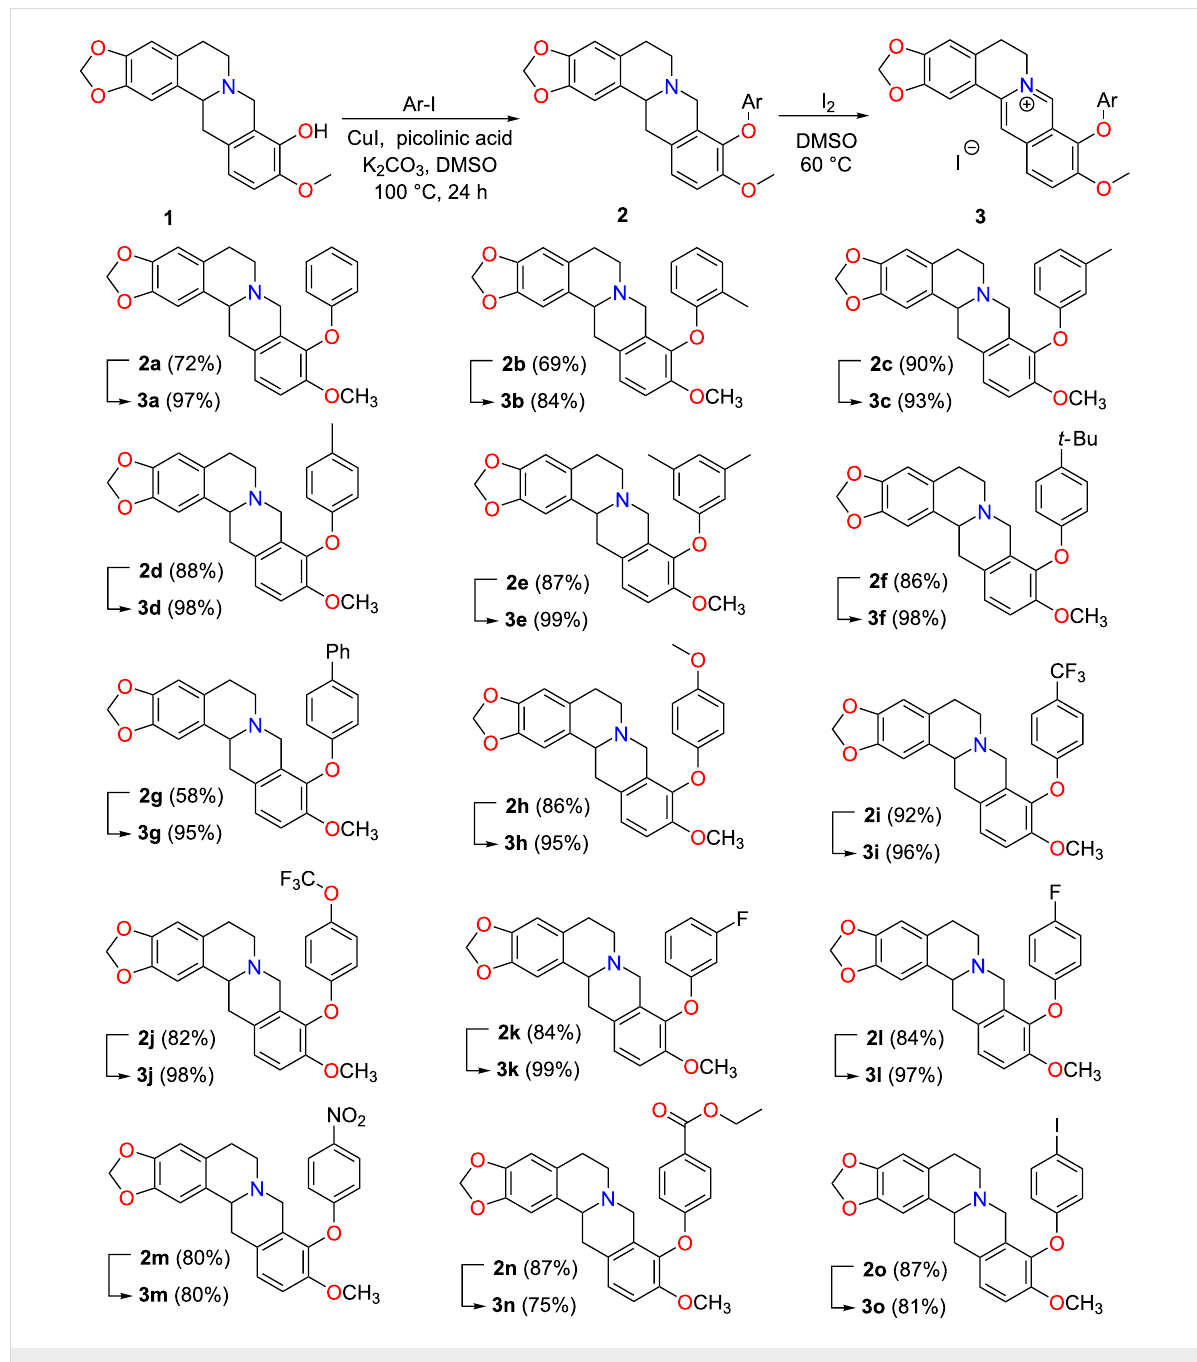
Scheme 3: 9-O-Aryl berberine scope via cross-coupling